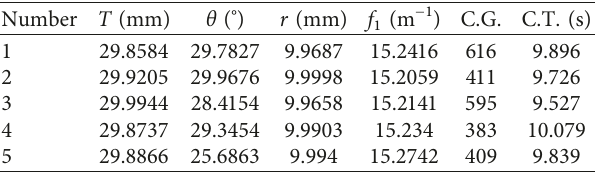
Table 2: Results obtained by SGA. Number T (mm)